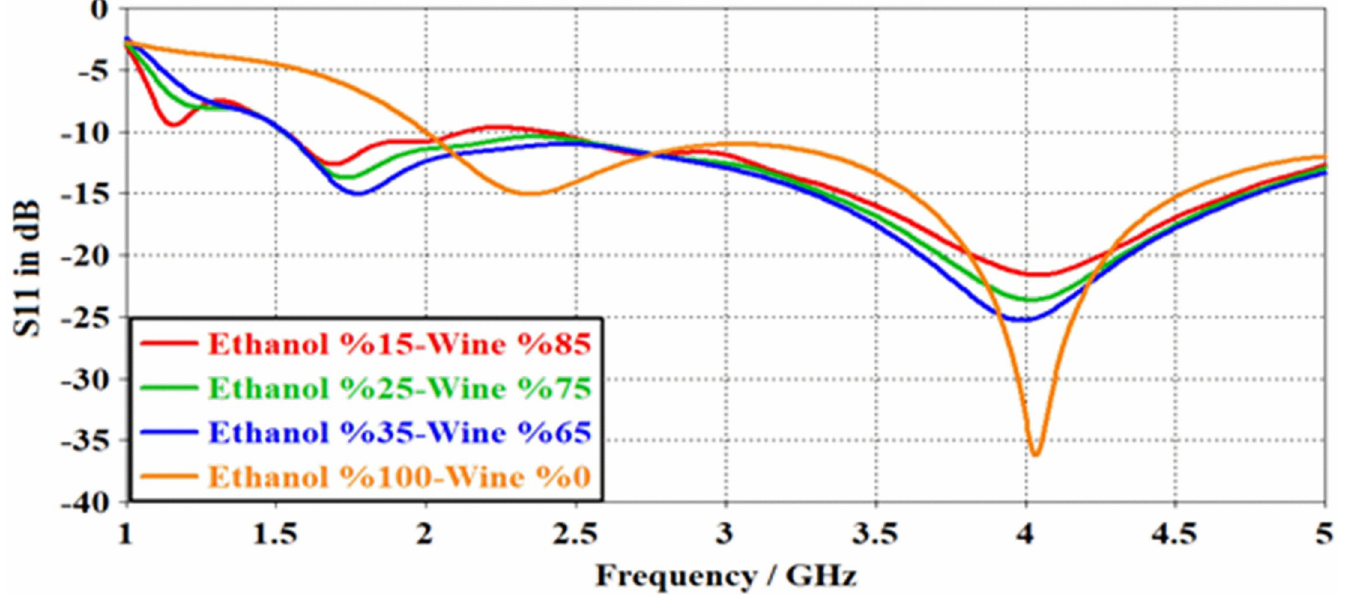
Fig 7. Simulation results of S11 spectra achieved by PCB rectangular patch antenna for the wine-ethanol sample.